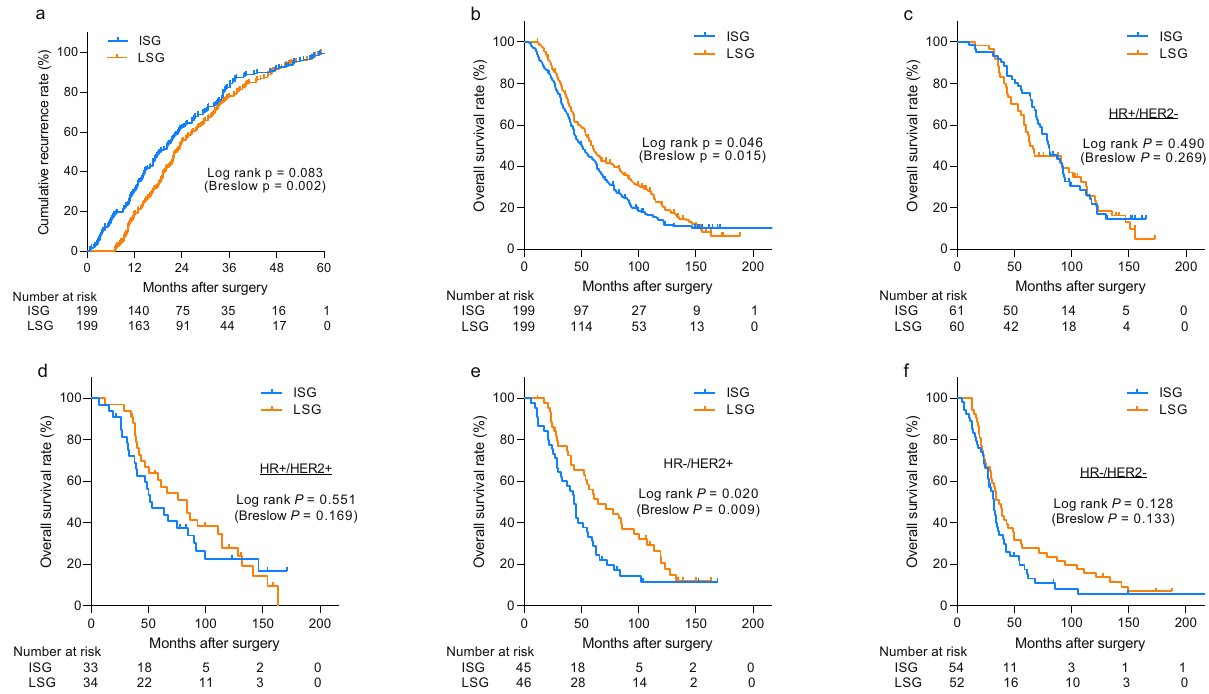
Figure 2. Kaplan–Meier curves showing recurrence-free survival and overall survival of all patients. The Kaplan–Meier curves show recurrence-free survival (a) and overall survival (b–f) . The survival curves for all 398 patients (b) and for patients stratified according to the hormone receptor and HER2-overexpression status (c–f) are shown. Among all, 13 patients were unable to obtain the data of subtypes. P-values were calculated by using the log-rank test along with Gehan–Breslow–Wilcoxon tests (in the parenthesis). ISG intensive surveillance group, LSG less-intensive surveillance group, HR hormone receptor, HER2 human epidermal growth factor receptor type